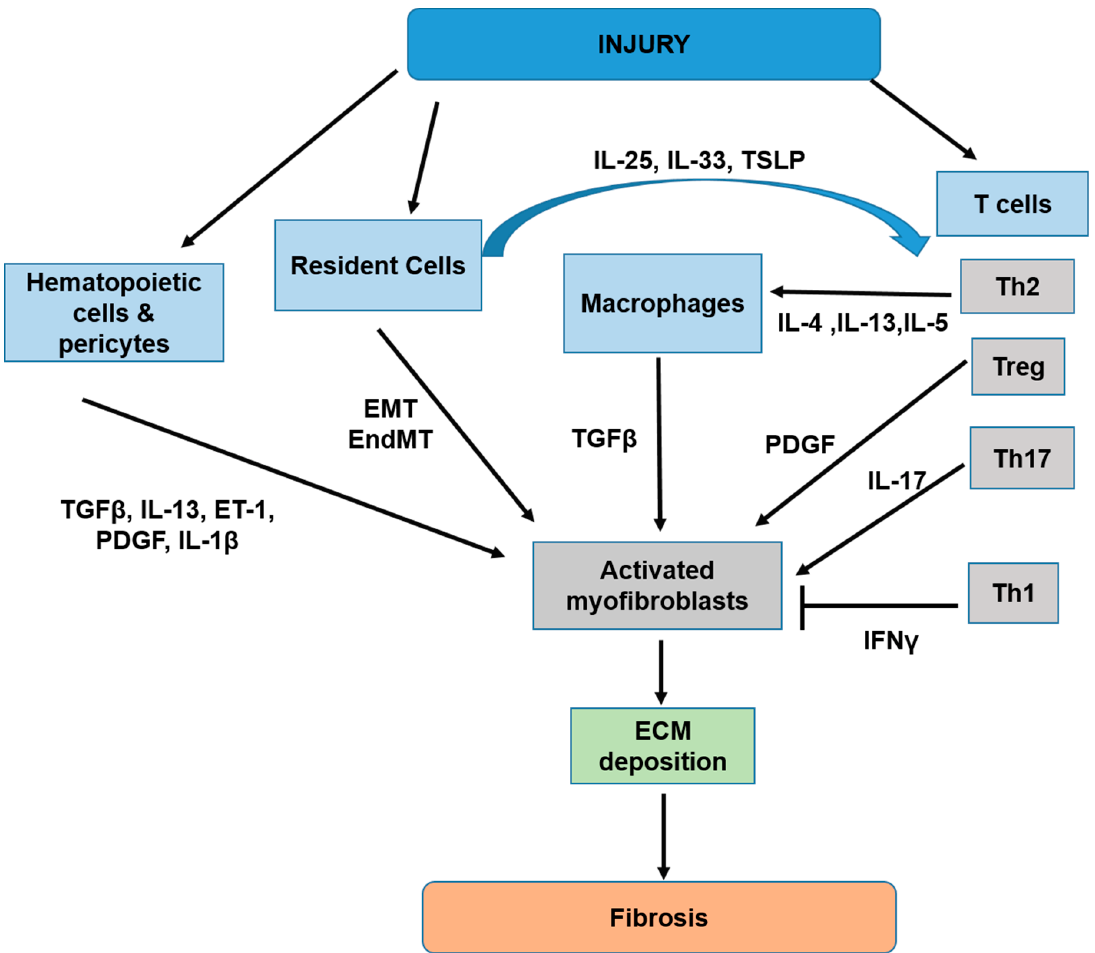
Figure 2. Major contributions of immune and non-immune cells in tissue fibrosis. During fibrosis, macrophages and T cells promote fibrosis via activation of myofibroblasts and release of pro-fibrotic inflammatory factors. Non-immune cells can also be transformed into “myofibroblast-like” cells to produce collagen factors that advance the progression of fibrosis. TGF, transforming growth factor; PDGF, platelet-derived growth factor; EMT, epithelial to mesenchymal transformation: EndMT, endothelial to mesenchymal transformation; ECM, extracellular matrix; TSLP, thymic stromal lymphopoietin; Endothelin-1 (ET).